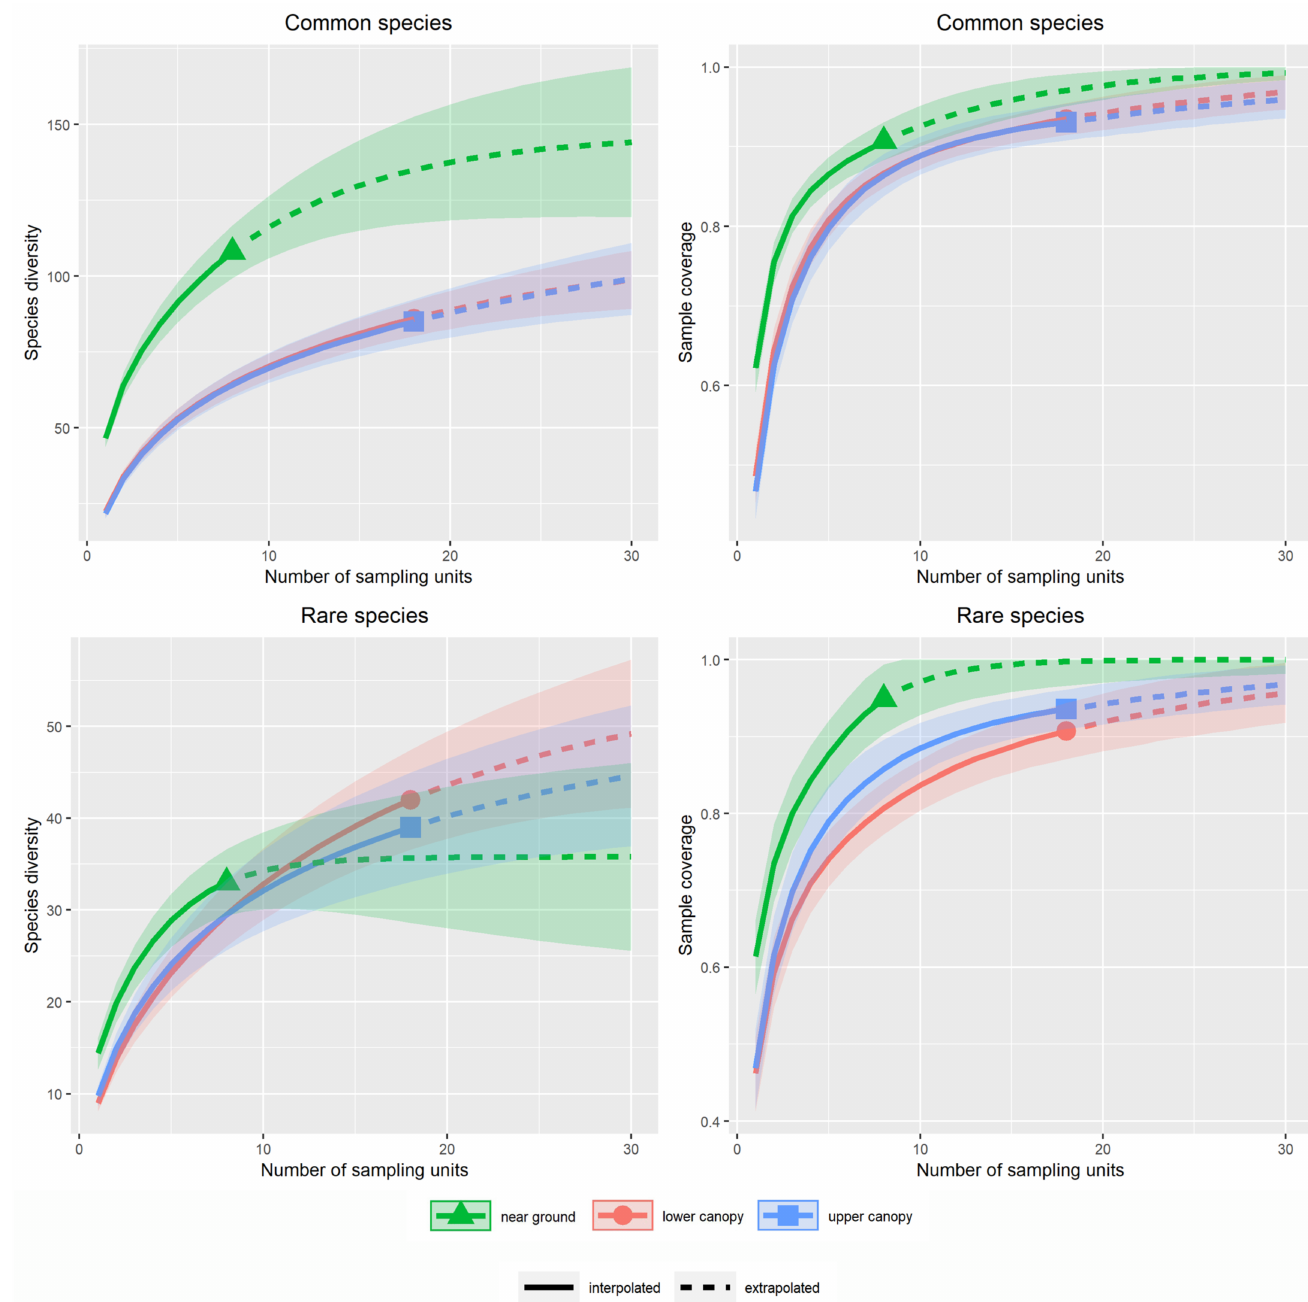
Figure 1. Comparison of species richness and sample coverage among the studied strata for rare and common beetle species, according to the red list definitions. The left column shows the estimated species richness against the number of traps per stratum. The right column shows the sample coverage against the number of traps per stratum. The bands mark the 95% confidence interval. No significant difference in species richness was found among the tree species, neither for the rare nor the common beetle species. This was true for both definitions of rarity (Figure 2, Figure